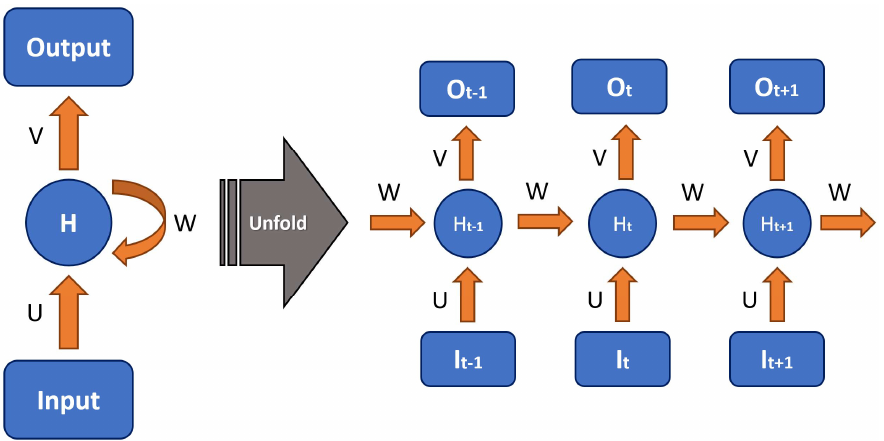
Figure 7. Unfolding a basic RNN. U, V, and W are the weights of the input layer, the output layer and the hidden state, respectively; H t , I t , and O t are the hidden state, input vector, and output result at time t, respectively. Because of the loop in RNN, gradients can flow backwards through unlimited numbers of virtual layers unfolded in space, so that they can be prevented from vanishing or exploding. And this loop also makes it possible for the RNN to process entire sequences of data.